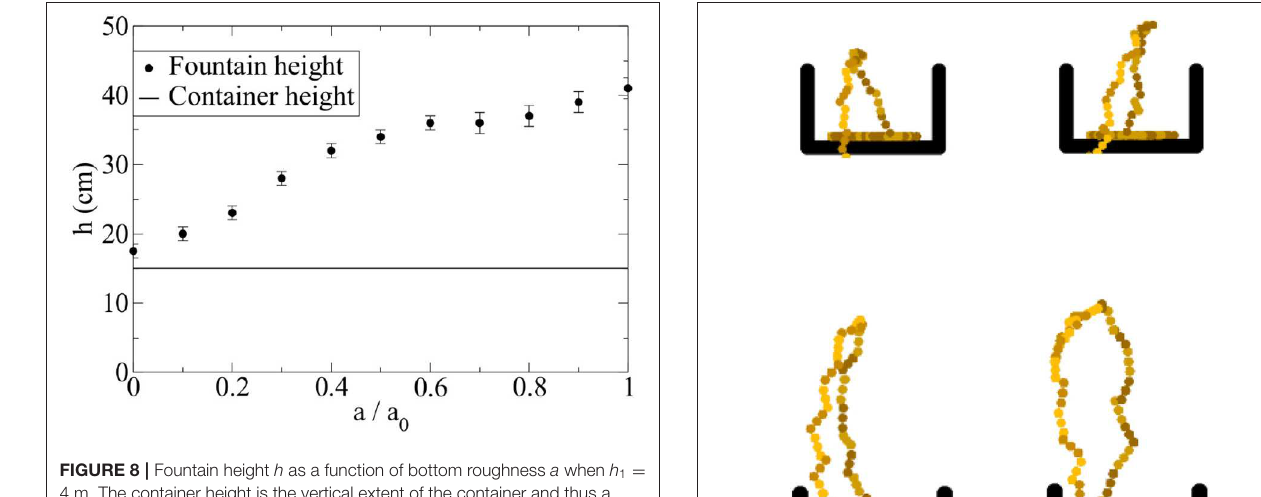
flexible chain, we may still inquire if there are any other chains that do not rely on the structure of the bottom. Indeed, Biggins [4] explored two additional chains, one that was composed of piecewise rigid segments, thus corresponding more closely to